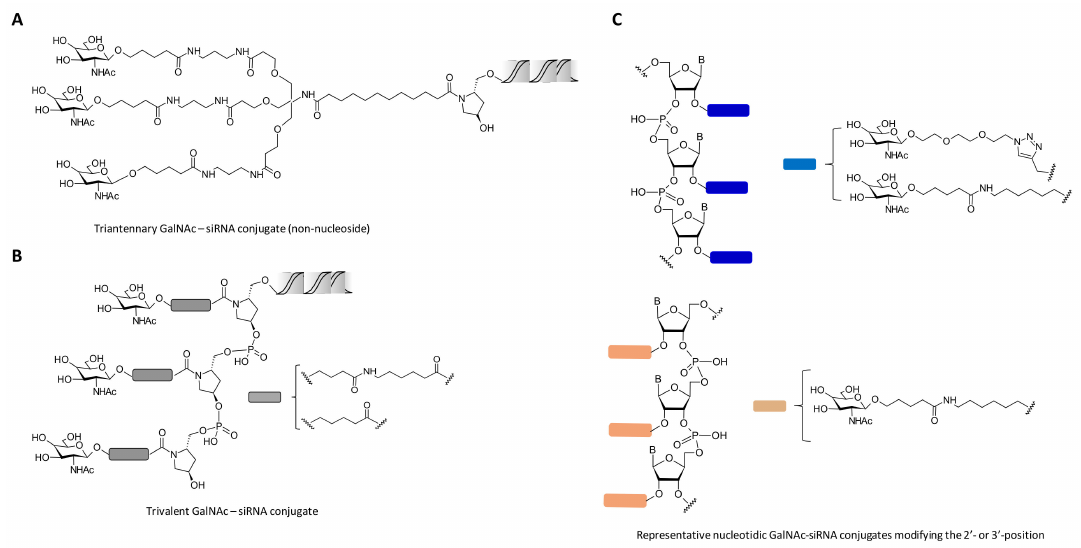
Figure 2. Schemes of carbohydrate_siRNA conjugates containing one triantennary GalNAc ( A ), three consecutive GalNAc residues ( B ) and nucleotides carrying monovalent GalNAc units at different positions of the siRNA duplex ( C ). Modifications were introduced at the 3 (cid:48) -termini of the siRNA passenger